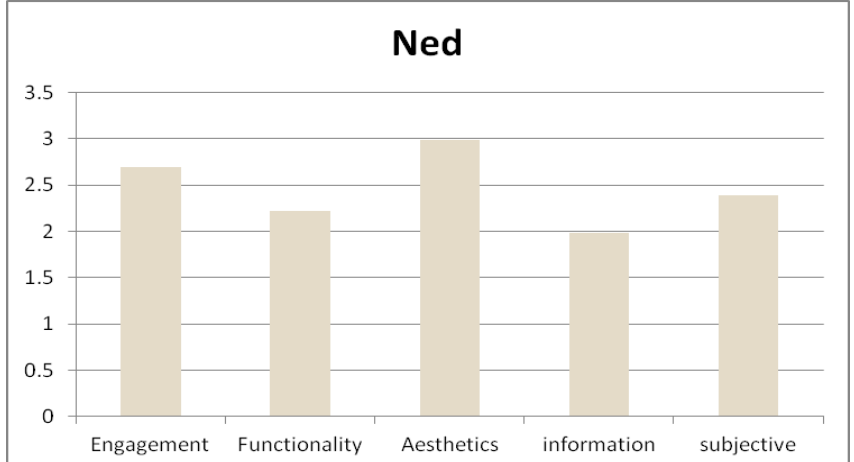
Fig 10. The evaluation of indicators in Ned according to MARS